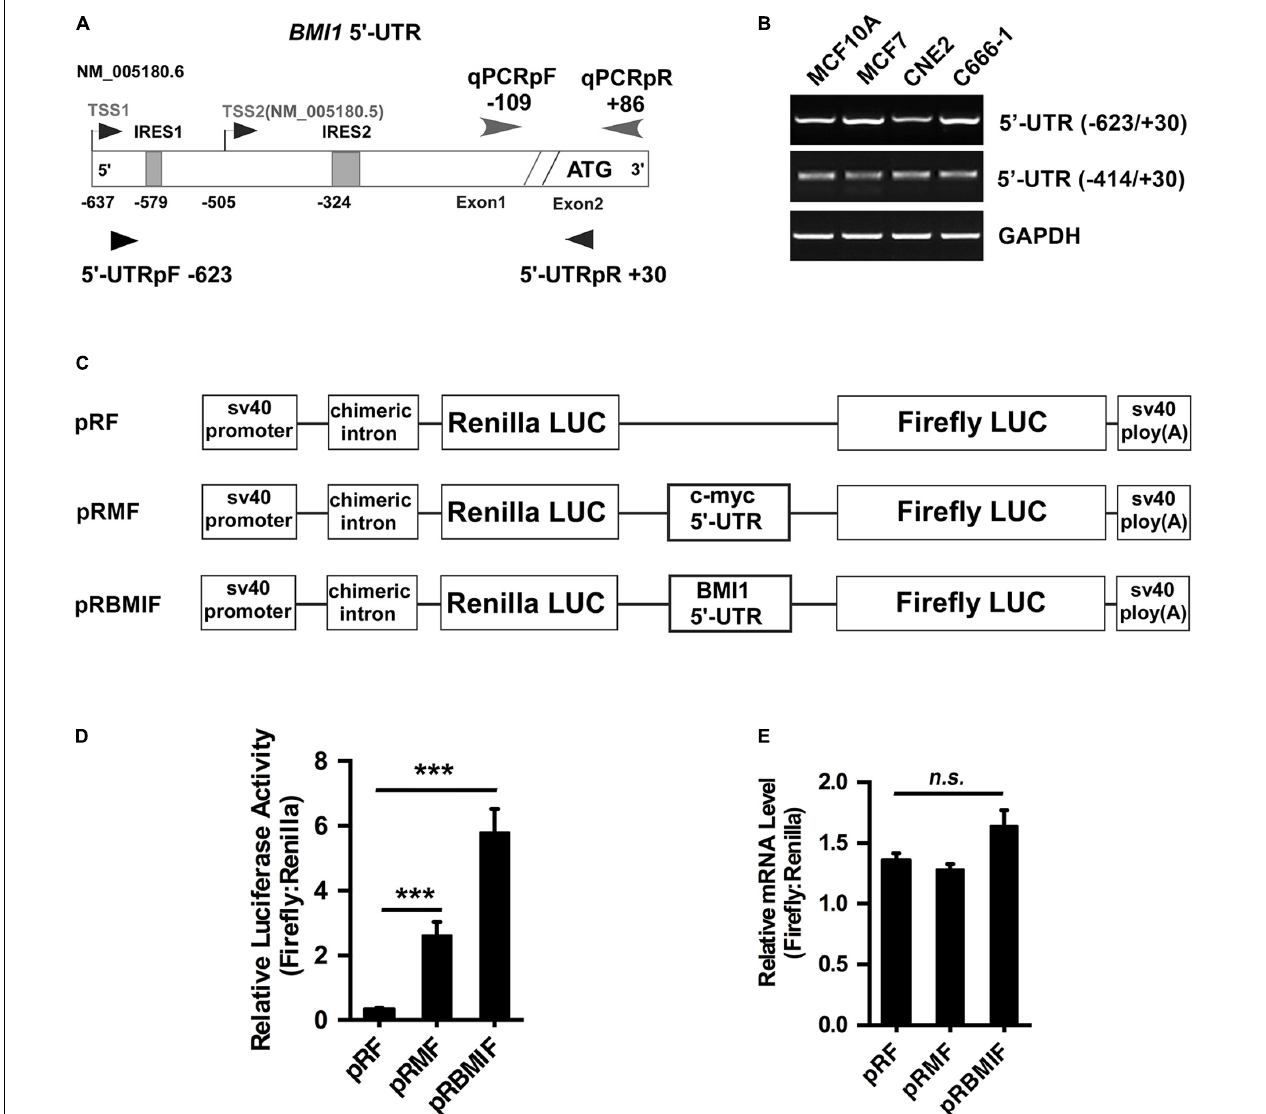
FIGURE 4 | The 5 (cid:48) -UTR promotes the translation of Bmi1 in CNE2 cells. (A) Diagram of the full-length Bmi1 5 (cid:48) -UTR. (B) The Bmi1 5 (cid:48) -UTR in CNE2, C666-1, MCF7, and MCF10A cells was analyzed by PCR. (C) Construction of the dicistronic reporter plasmid. The 5 (cid:48) -UTRs of c-myc and Bmi1 were subcloned between the Renilla and the Firefly luciferase in the dual luciferase vector pRF, named as pRMF and pRBMIF, respectively. The plasmid pRMF served as the positive control. (D) The translational activity analysis of the 5 (cid:48) -UTR in CNE2 cells. The plasmids pRF, pRMF, and pRBMIF were transfected into CNE2 cells. Luciferase activity was detected 24 h post-transfection and presented as relative internal ribosome entry sites activity (Firefly luciferase/Renilla luciferase). (E) The mRNA expression ratio of Firefly to Renilla luciferase in CNE2 cells. A representative result of three independent experiments is shown ( n = 3). The graphs show the mean ± SEM. *** P < 0.001; Student’s t